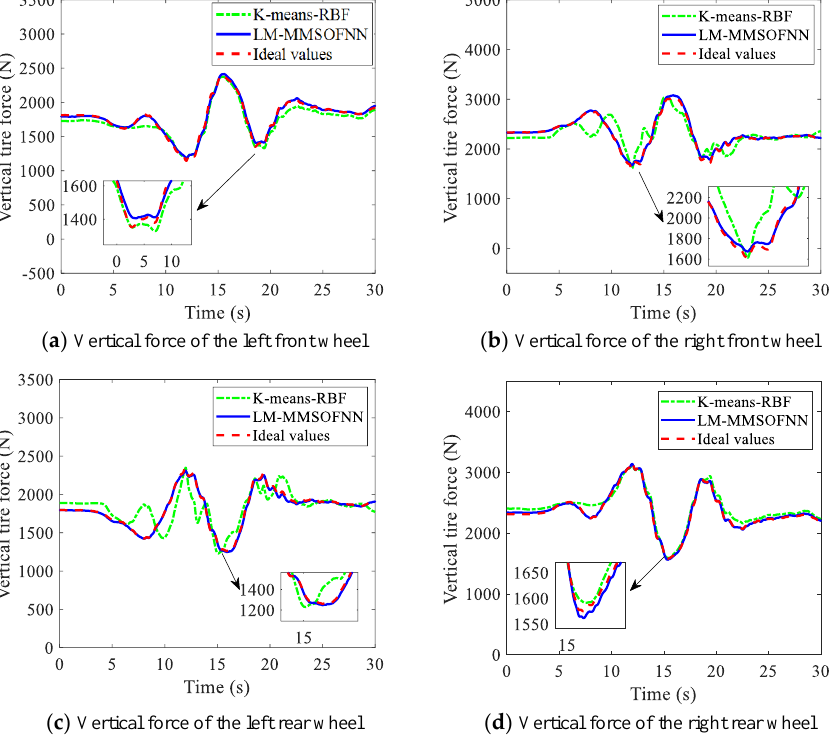
Figure 20. The lateral tire force of four wheels.